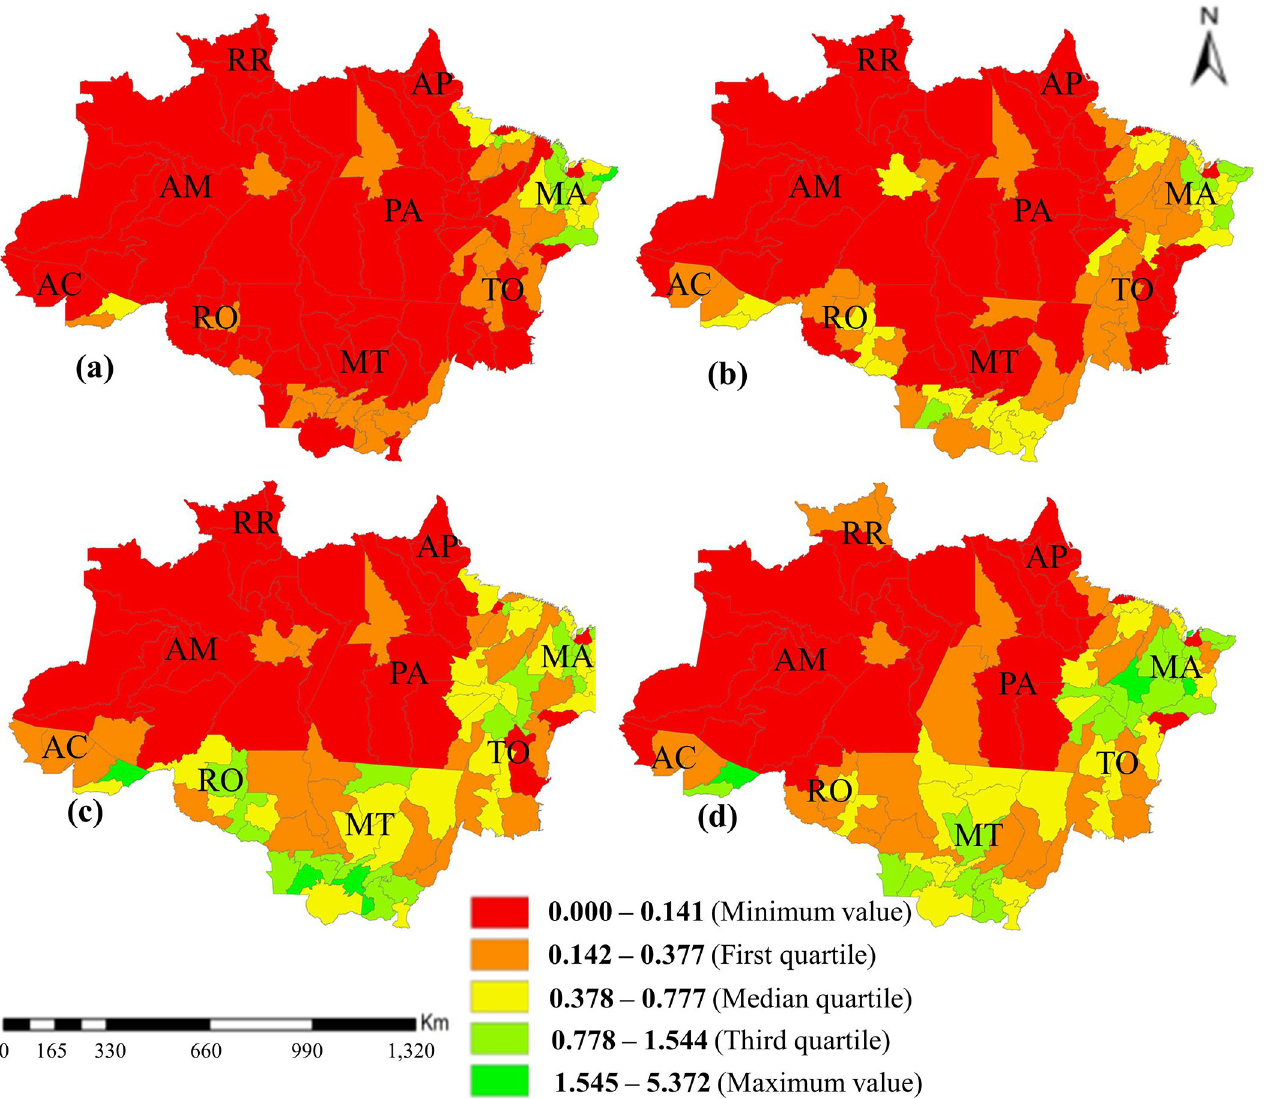
Fig 3. Sheep herd density per km 2 in Legal Amazon (a.1990, b.2000, c.2010, d.2020). RO, Rondoˆnia; AC, Acre; AM, Amazonas; RR, Roraima; PA, Para´; AP, Amapa´; TO, Tocantins; MA, Maranh ã o; MT, Mato Grosso.